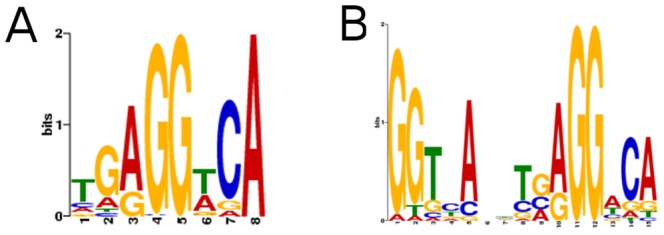
Definition of TRE Consensus.A. Consensus sequence with similarity to the classic TRβ binding half-site discovered by analysis of top 150 peaks in BioChIP analysis. B. The previously defined TRβ consensus obtained from analysis of more than 30 published target gene regulatory elements is shown for comparison at right.